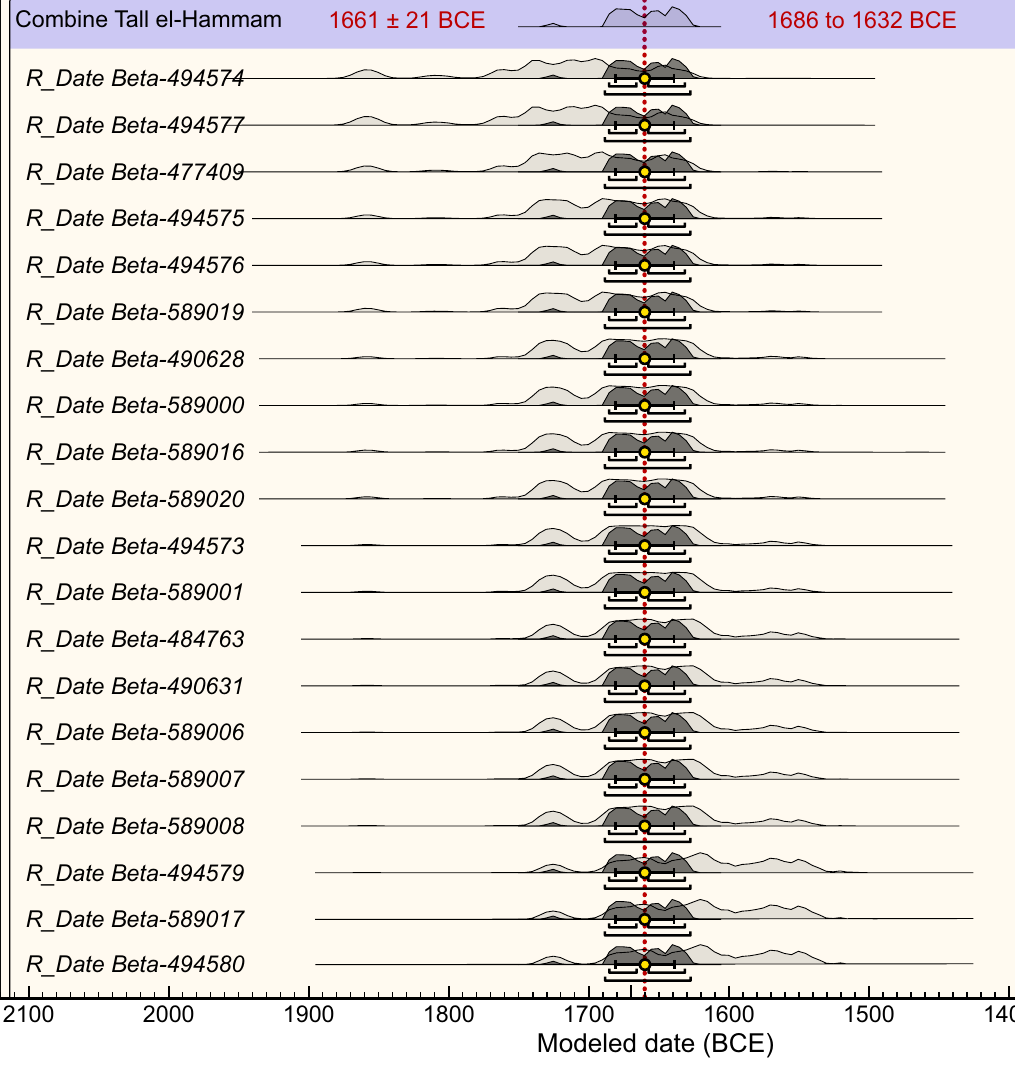
Figure 5. Bayesian analysis. Using OxCal v.4.4.4 18–20 , the ‘Combine’ computer routine determined that 20 of 26 14 C dates are statistically synchronous and likely represent a single event at 1661 ± 21 BCE (1686–1632 BCE), rounded to 1650 BCE. Light gray curves represent unmodeled calibrated ages; dark gray represents modeled calibrated ages. The white dot beneath the curves equals the mean age, also represented by the red dotted vertical line. Progressively longer brackets beneath curves represent 68% and 94% confidence intervals. The program performed two statistical probability tests to test the robustness of the model. Both the A comb and Chi Sq statistical tests show a high probability, indicating that the modeled age of 1661 ± 21 BCE is likely to be